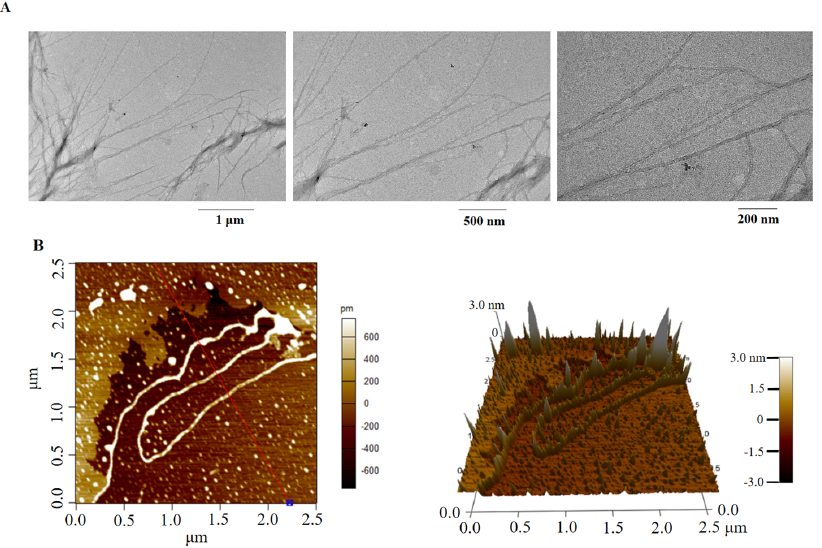
Figure 6. Morphological analysis of EPS2 − 1. ( A ) TEM images (12,000×, 20,000×, 40,000×); ( B ) AFM images of EPS2 − 1.